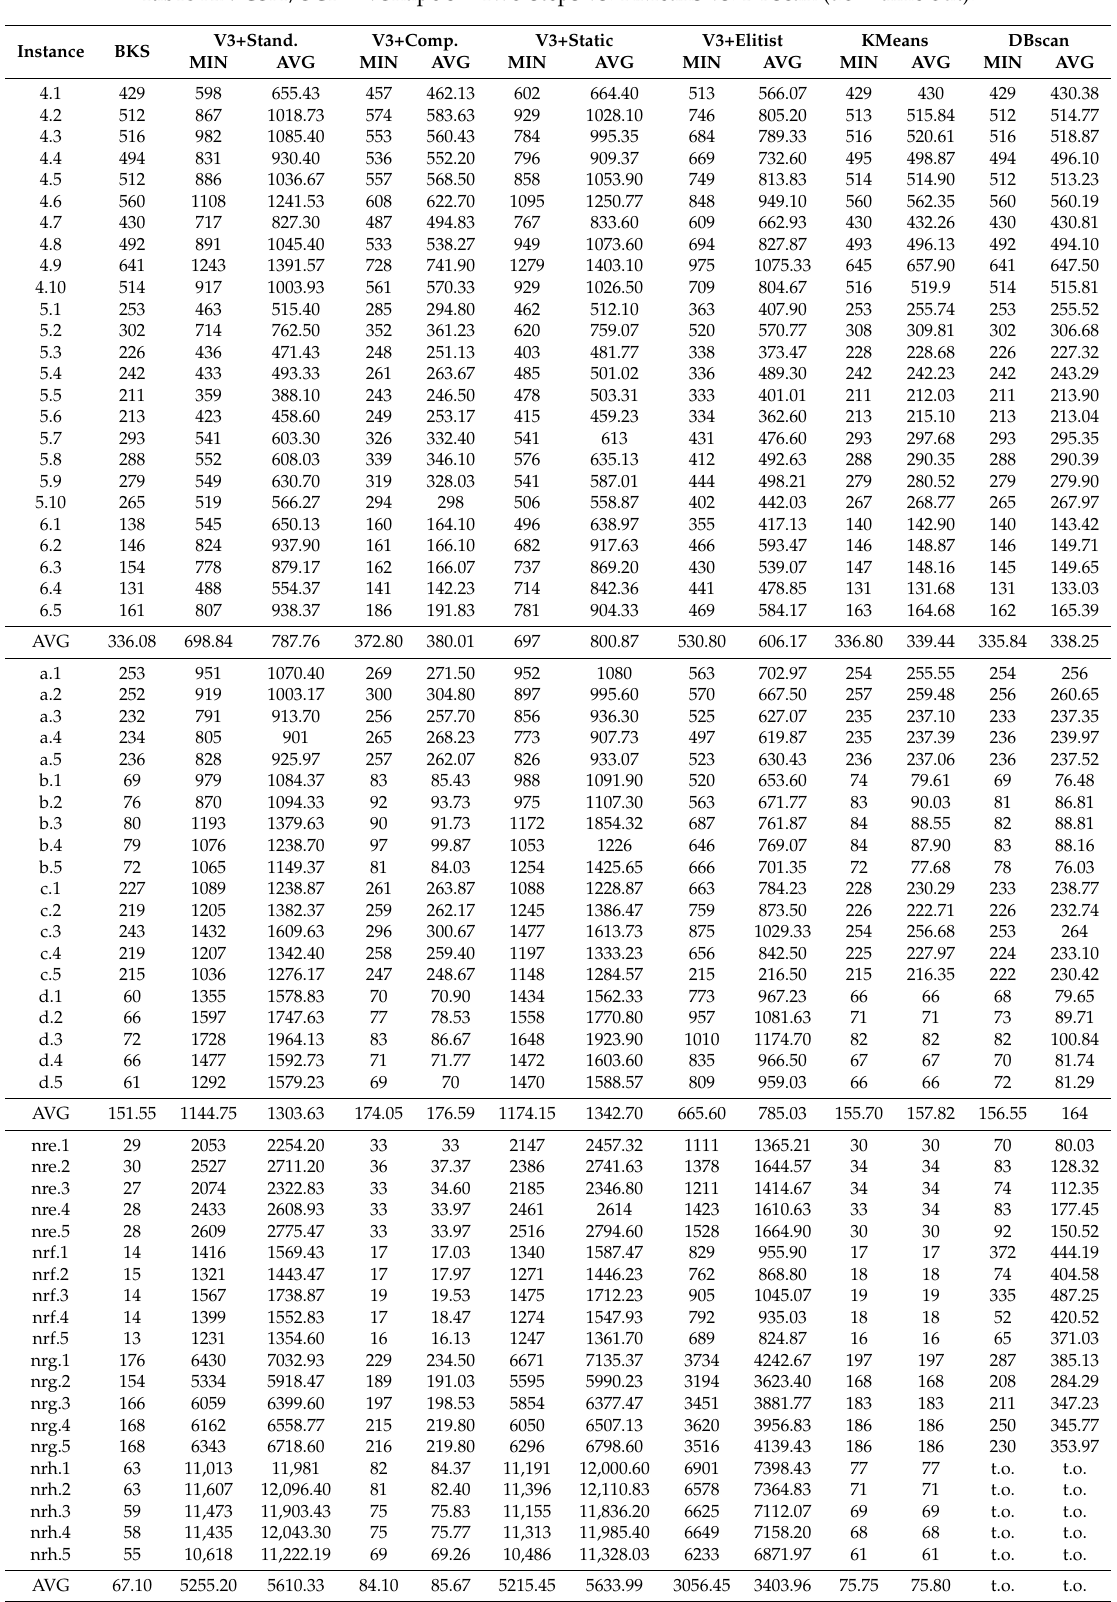
Table A7. CSA/SCP—VShape 3—Two-steps vs. KMeans vs. DBscan (t.o = time